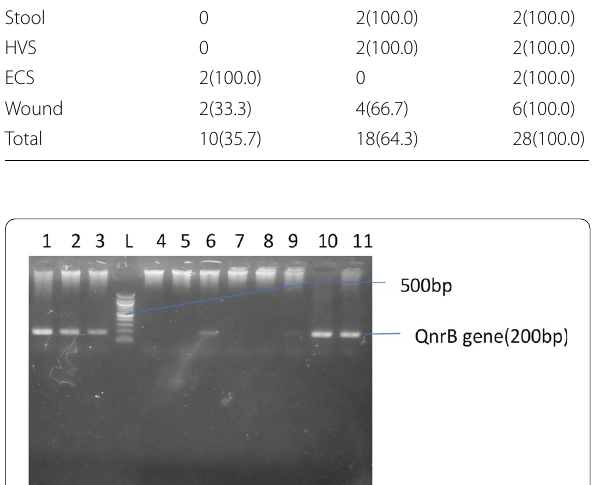
Fig. 1 A representative of the agarose gel electrophoresis of qnrB gene